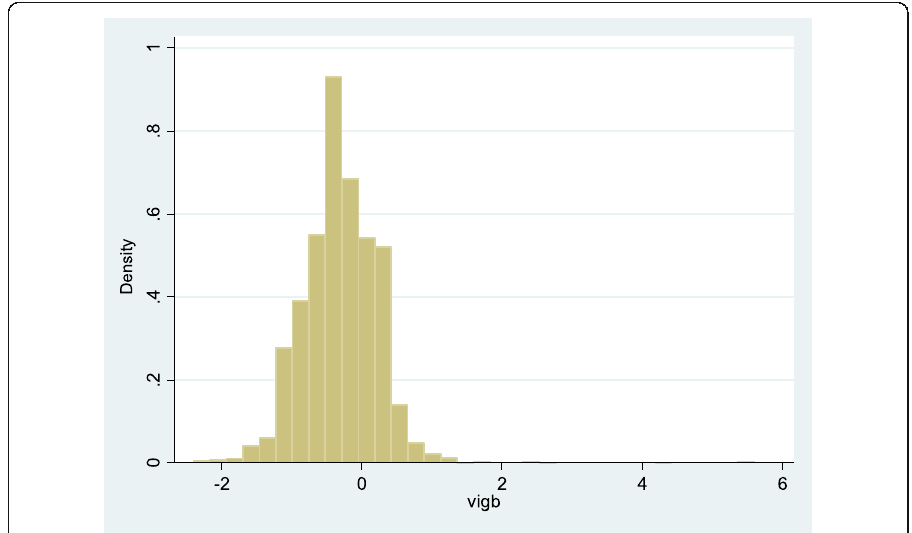
Fig. 7 Distribution of individual reporting heterogeneity from vignette set B. Note: Health domains in set B includes pain and personal